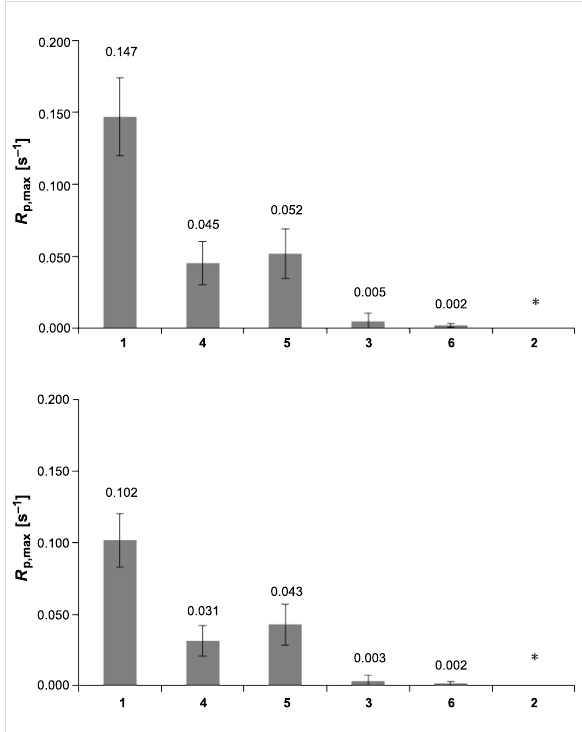
Figure 4: R p, max for the curing of 1–6 at 37 °C for a) top: ∆ H p of allyl groups = 87.5 kJ·mol − 1 and b) bottom: ∆ H p of allyl groups = 43.7 kJ·mol − 1 (*no polymerization heat